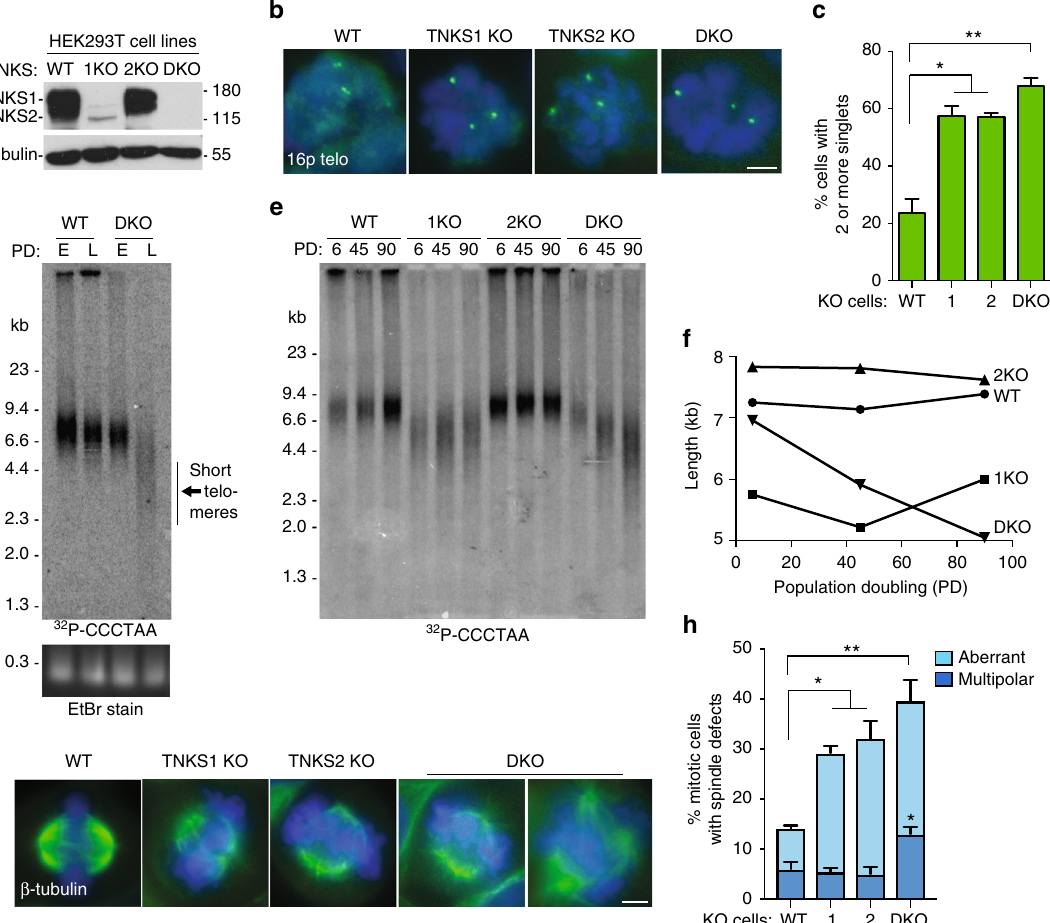
Fig. 1 Generation and functional analysis of human tankyrase knockout cell lines. a Immunoblot analysis of whole cell lysates from HEK293T knockout (KO) cell lines generated by CRISPR-Cas9 stained with antibody that detects tankyrases 1 and 2. b FISH analysis of mitotic HEK293T WT, 1KO, 2KO, or DKO mitotic cells with a 16p telo probe (green). HEK293T cells are trisomic for chromosome 16. DNA was stained with DAPI. Scale bar, 5 μ m. c Quanti fi cation of the frequency of mitotic cells with cohered telomeres. Average of two independent experiments ( n = 80 cells) ± SEM. * p ≤ 0.05, ** p ≤ 0.01, students unpaired t -test. d Analysis of telomere restriction fragments isolated from HEK293T WT or TNKS DKO cells isolated from an early (E) time immediately following the CRISPR-Cas9 screen and at a late (L) time point following passaging for ~2 months, fractionated on agarose gel, denatured, and hybridized with a 32 P-[CCCATT] 3 probe. EtBr stain of total DNA is below. e Analysis of telomere restriction fragments isolated from HEK293T WT, 1KO, 2KO, or DKO cells isolated from population doubling (PD) 6, 45, or 90, fractionated on agarose gel, denatured and hybridized with a 32 P-[CCCATT] 3 probe. f Graphical representation of the mean telomere length determined using Telometric (Fox Chase Cancer Center). g Immuno fl uorescence analysis of HEK293T WT, 1KO, 2KO, or DKO cells following fi xation with 2% paraformaldehyde and stained with β -tubulin antibody (green) and DAPI (blue). Scale bar, 5 μ m. h Quanti fi cation of the frequency of cells with defective mitotic spindles. Average of two independent experiments ( n = 66 – 71mitotic cells each) ± SEM. * p ≤ 0.05, ** p ≤ 0.01, Student ’ s unpaired t